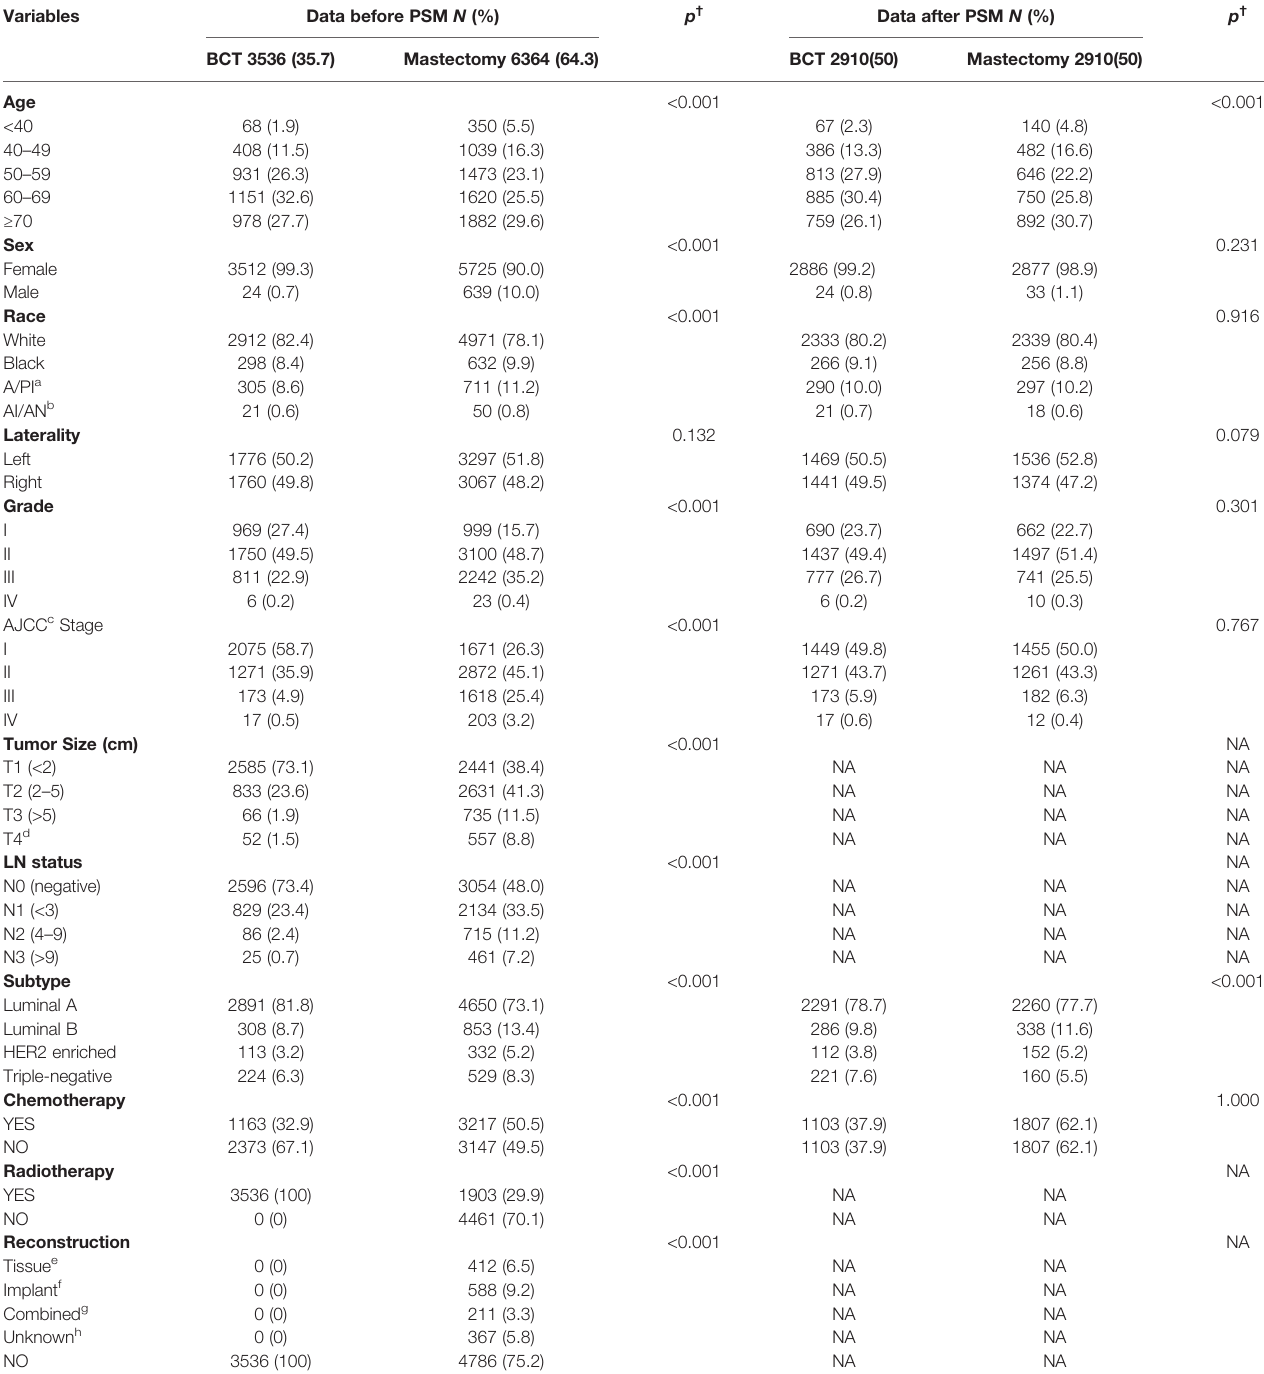
TABLE 1 | Clinicopathological features of the central and nipple breast cancer patients.